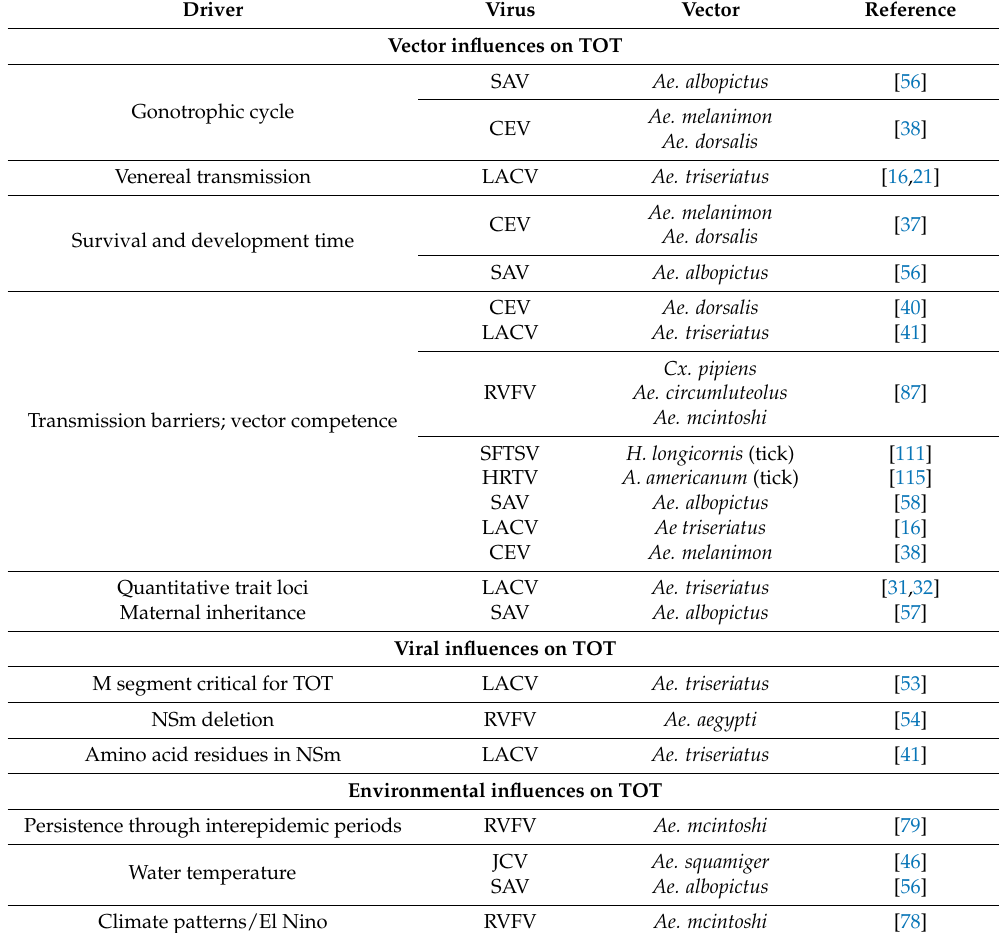
Table 2. Summary of known drivers of TOT efficiency with exemplary virus/vector